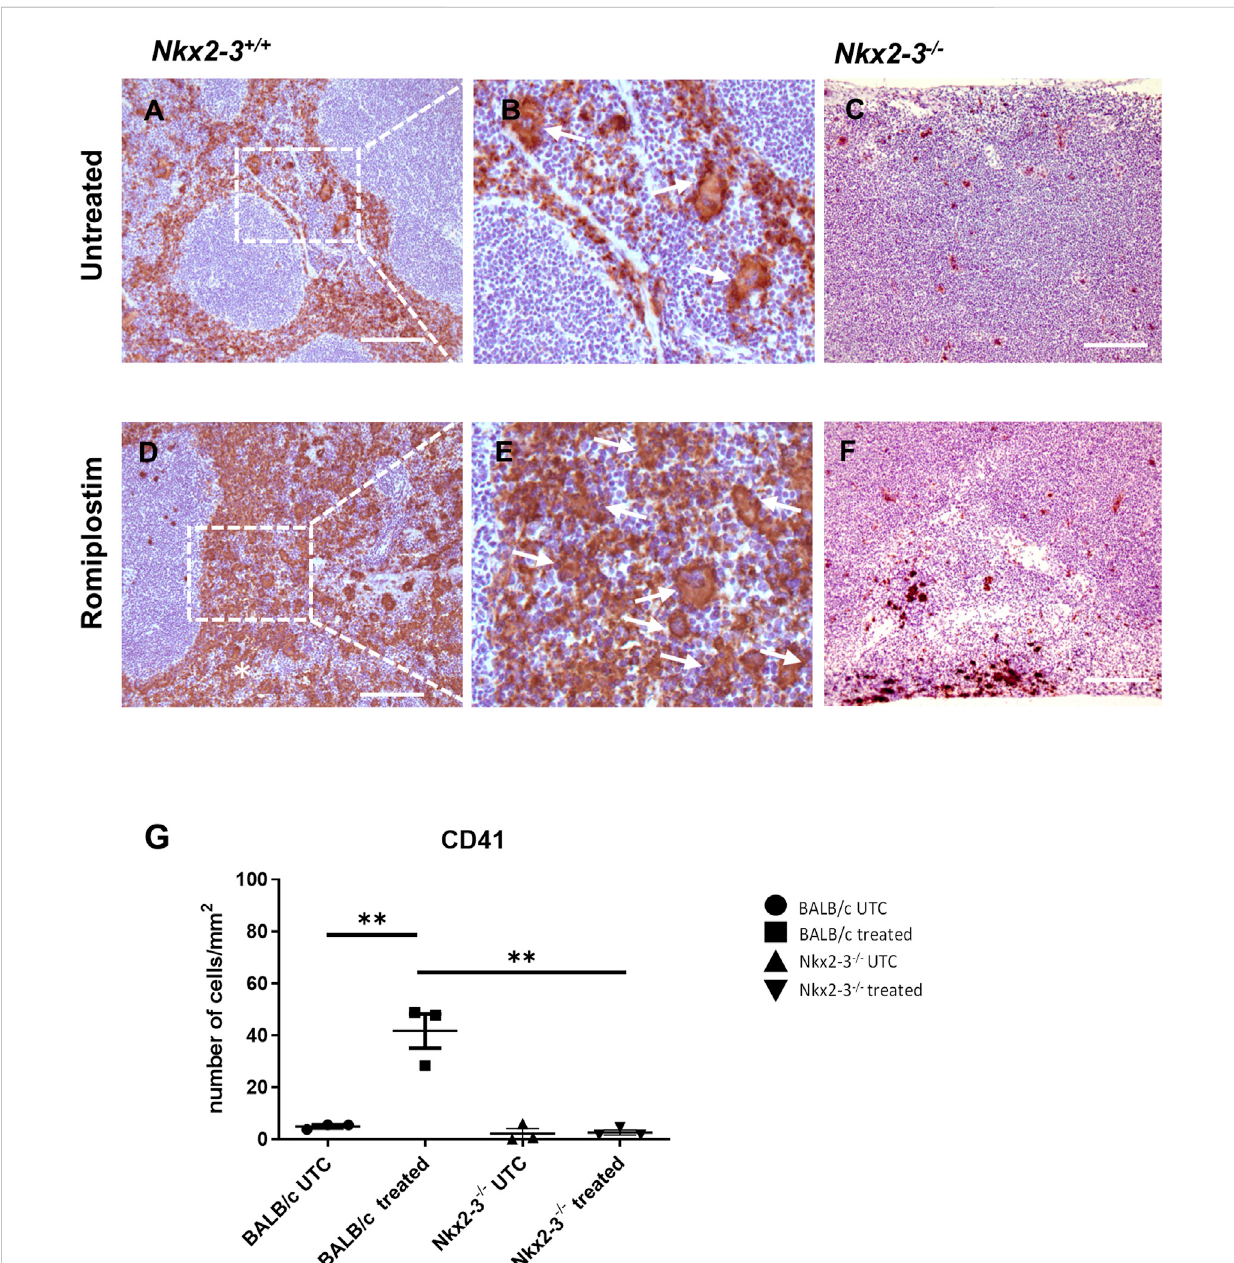
FIGURE 7 TPO-agonist treatment fails to induce splenic megakaryocyte expansion in mice lacking Nkx2-3. Representative images show megakaryocyte labeling of BALB/c or Nkx2-3 − / − (indicated at the top) spleen using anti-CD41 immunohistochemistry (visualized as brown reaction product, with hematoxylin counterstain) before (untreated, (A – C) and after Romiplostim treatment (D – F) , indicated on the left. Higher power inserts (B, E) corresponding to the dashed rectangle demonstrate single megakaryocytes restricted to the RP. In the samples after Romiplostim treatment the arrows in the high-power insert (corresponding to the rectangle) label multinucleated megakaryocytes typically arranged in pairs. Representative micrographs from a cohort of n = 4. Scale bars correspond to 100 μ m. Graphs demonstrate the number of CD41 + cells per 1 mm 2 in BALB/c (UTC n = 3, treated n = 3) and Nkx2-3 − / − (UTC n = 3, treated n = 3) mice (G) . ** p < 0.01 by unpaired t -test and Mann Whitney U test (G)